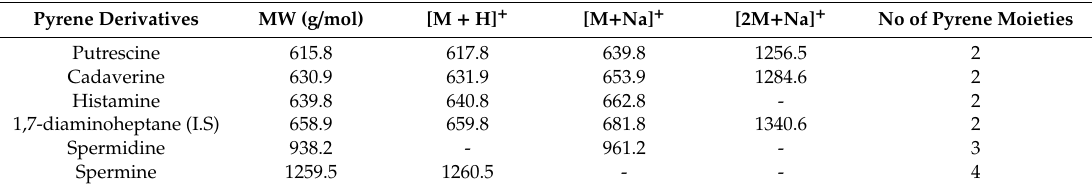
Table 2. Identified m / z ions of the pyrene derivatives of BAs and internal standard (I.S.) by LC-ESI-MS. Pyrene Derivatives MW (g / mol) [M + H] + [M + Na] + [2M + Na] + No of Pyrene Moieties